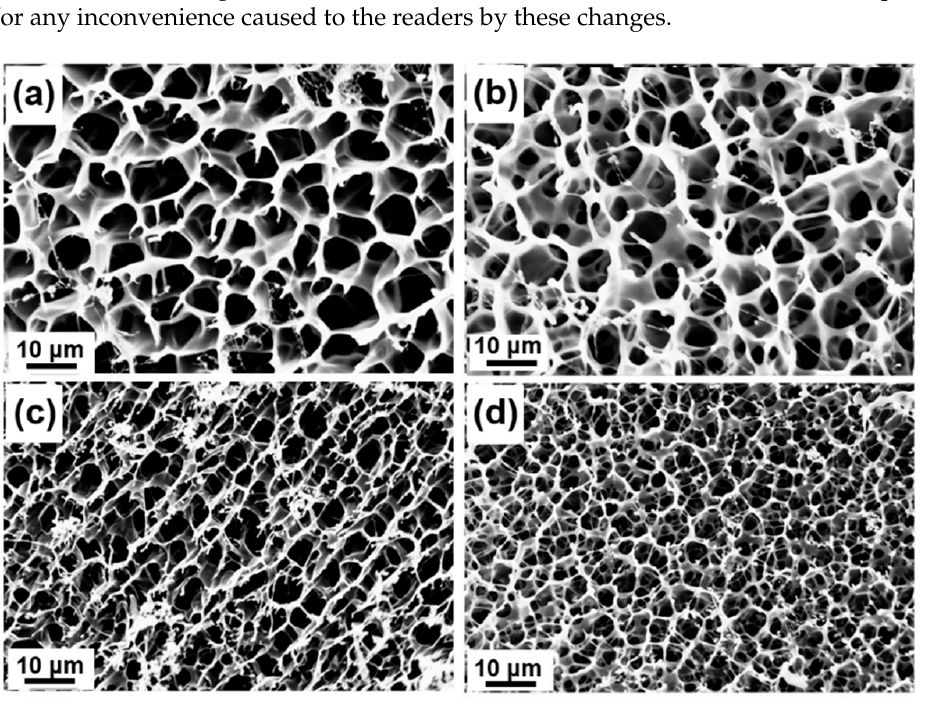
Figure 4. SEM images of homogeneous peptide-based bis-acrylate/AAc hydrogels before biodegra- dation: ( a ) Gel-1; ( b ) Gel-2; ( c ) Gel-3; ( d ) Gel-4. With the increase in the peptide-based bis-acrylate content, the pore size of the hydrogels decreases.